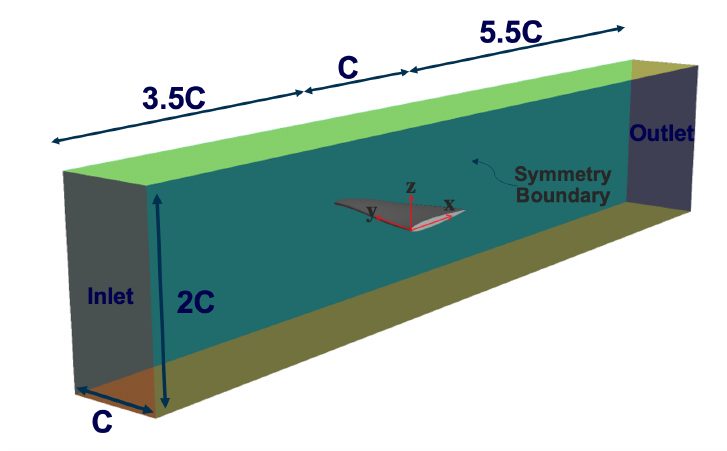
Figure 2. Computational domain employed in the current numerical